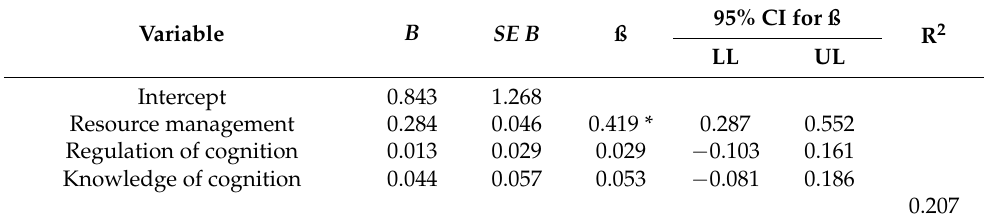
Table 7. Avoiding distraction regression